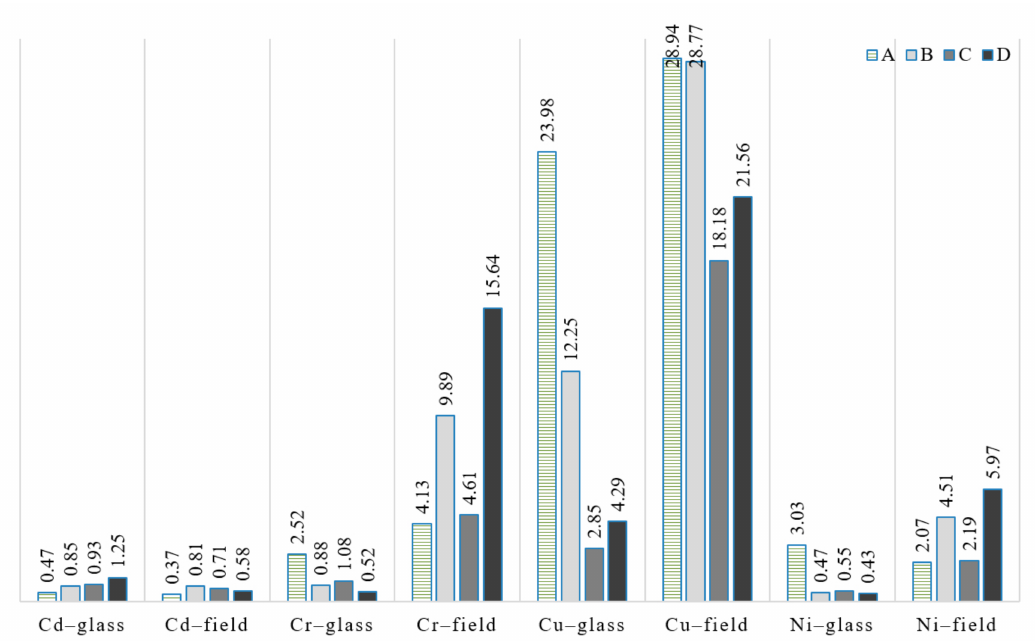
Figure 7. Average content of Cd, Cr, Cu and Ni in the test plants cultivated in the greenhouse and in the field (in mg · kg − 1